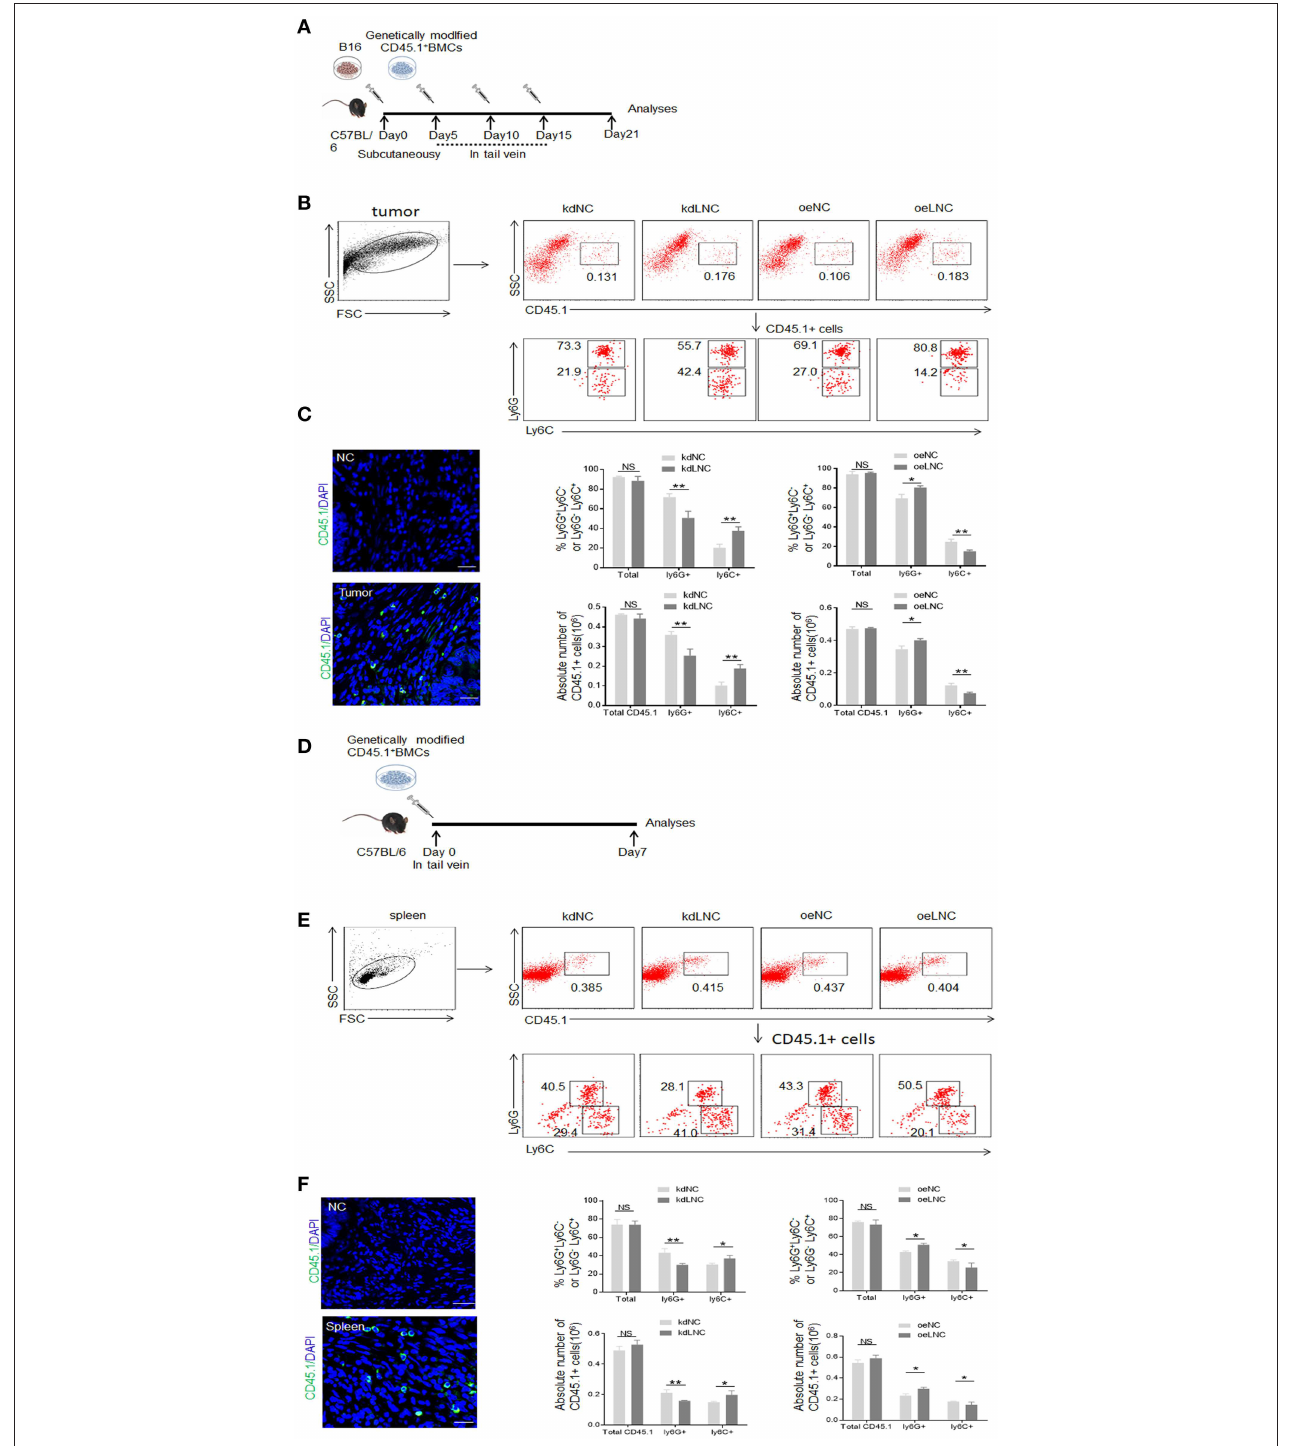
FIGURE 3 | Lnc-C/EBP β promotes differentiation of PMN-MDSC but impedes Mo-MDSC in vivo . (A) Schematic of the experiment. Lnc-C/EBP β lentivirus treated CD45.1 + BMCs were injected into B16 tumor bearing WT mice in tail vein, and after 21 days the tumor CD45.1 cells were analyzed. (B) Flow cytometry of MDSCs in mouse tumor after injecting lnc-C/EBP β lentivirus treated CD45.1 + BMCs. The percentage changes and absolute cell number of CD45.1 + cell of MDSC subsets were compared ( n = 6). (C) Confocal microscopy of CD45.1 + cells in tumor. Green, CD45.1; blue, DAPI; NC, isotypic Ab. Scale bars = 100 µ m. (D) Schematic of